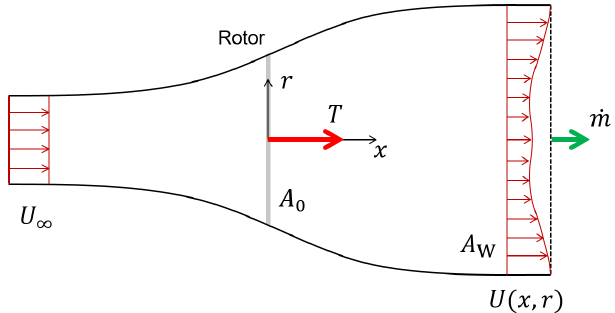
Figure 1. Stream tube with nomenclature: U ∞ is the ambient wind speed; U ( x,r ) is the local flow velocity in the wake at the down- stream position x and radial distance r from the wake centerline; ˙ m is the mass flow rate through the stream tube; A W is a planar cross-sectional area large enough to contain the wake deficit; A 0 is the rotor disk area; and T is the thrust force (by the principle of ac- tion and reaction, an equal and opposite force is applied by the rotor onto the